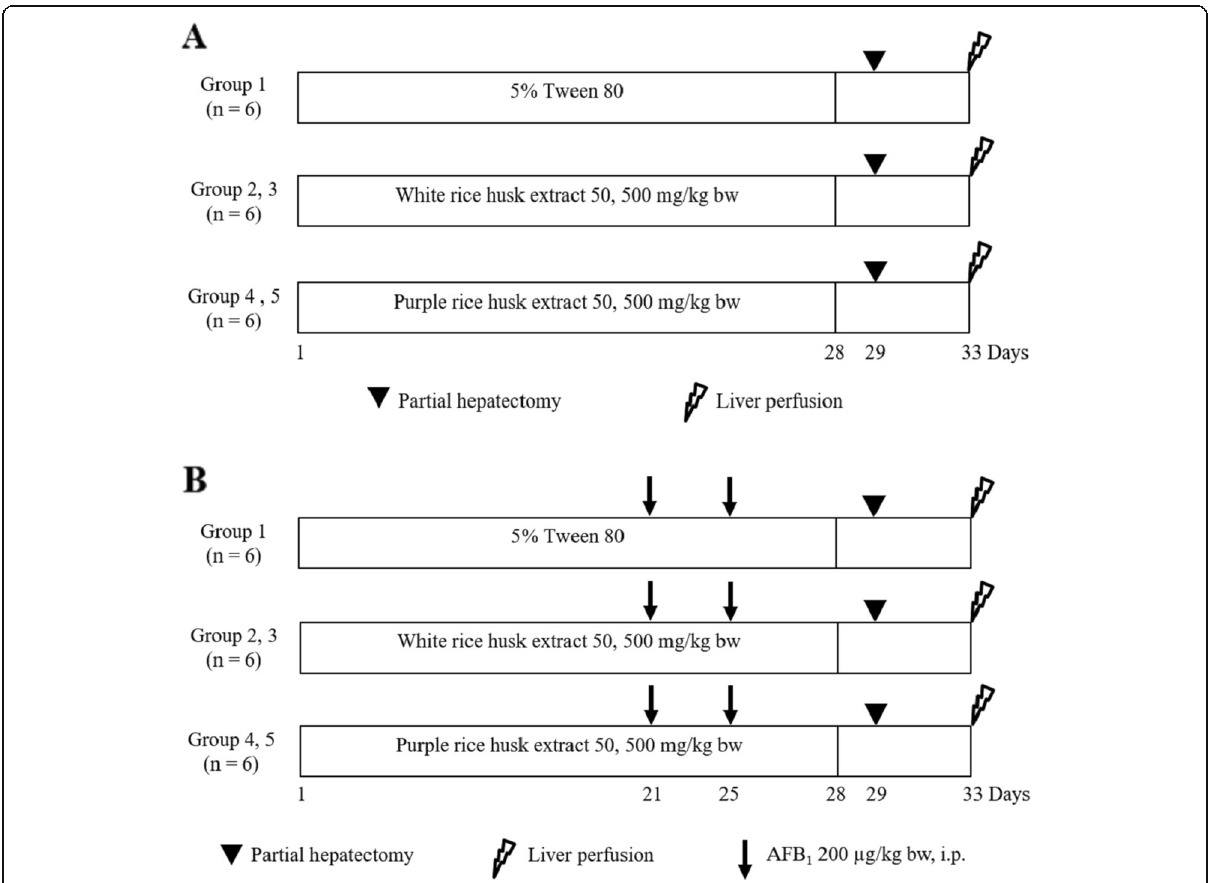
Fig. 1 The protocols for ( a ) genotoxicity and ( b ) antigenotoxicity of rice husk extracts in